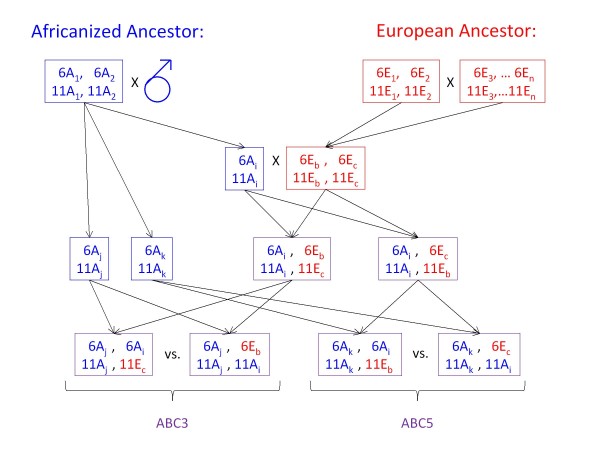
Possible genetic model of the inheritance of the observed transgressive ovary sizes, focusing on the two major QTL on chromosome 6 and chromosome 11 in the two backcrosses ABC3 and ABC5. Possibly different alleles are indicated by subscripts. The crossing scheme does not allow for different alleles from the Africanized ancestor to segregate at one locus. Thus, the differences between ABC3 and ABC5 must be caused by dominance or epistasis effects.